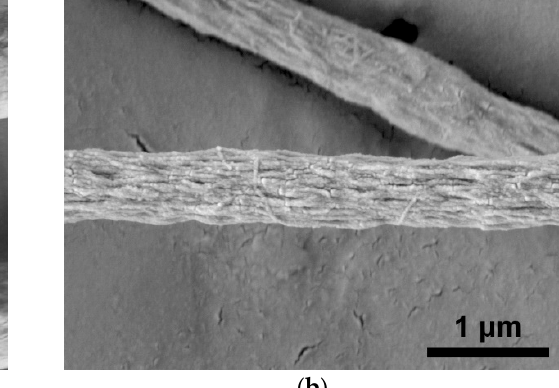
Figure 1. SEM images of ( a ) P30 fiber, ( b ) P60 fiber, ( c ) CP30 fiber, and ( d ) CP60 fiber. Insets show the cross-sectional SEM images of each fiber.